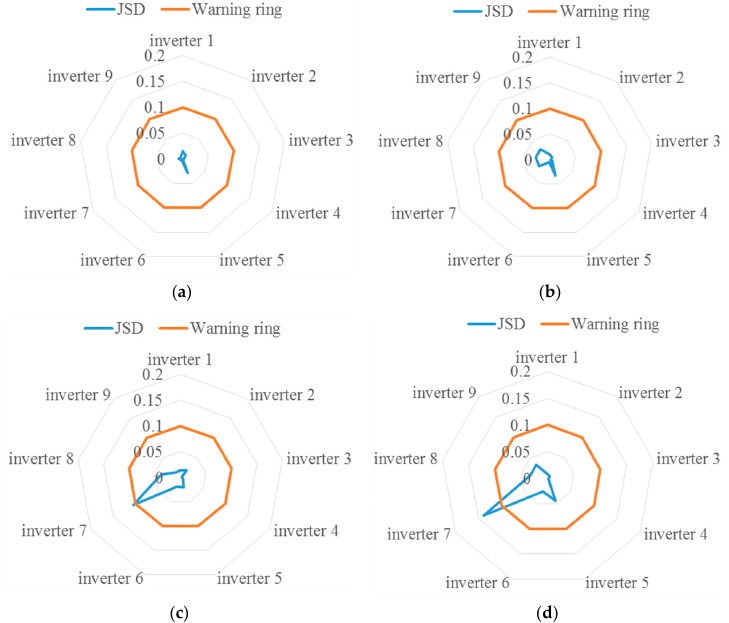
Figure 10. Gaussian mixture model between the center inverter and the PV inverter to be evaluated: ( a ) inverter 4 in May 2017; ( b ) inverter 7 in May 2017; ( c ) inverter 4 in November 2017; ( d ) inverter 7